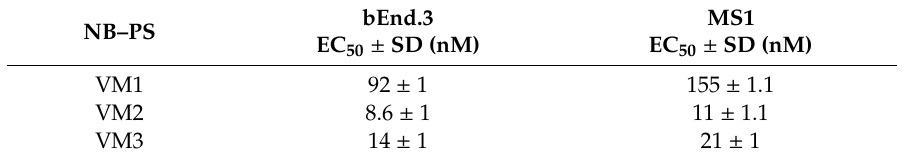
Figure 4. In vitro nanobody-targeted PDT in monoculture. The percentage of cell viability 24 h after illumination relative to the non-treated cells. Cells were incubated with different concentrations of the NB–PS conjugates for 1 h at 37 ℃ and illuminated with 7 mW/cm 2 fluence rate and a total light dose of 20 J/cm 2 using a 690-nm diode laser through a 600- μ m optic fiber. Table 1. EC 50 values obtained from nanobody-targeted PDT of two murine endothelial cell lines. NB–PS